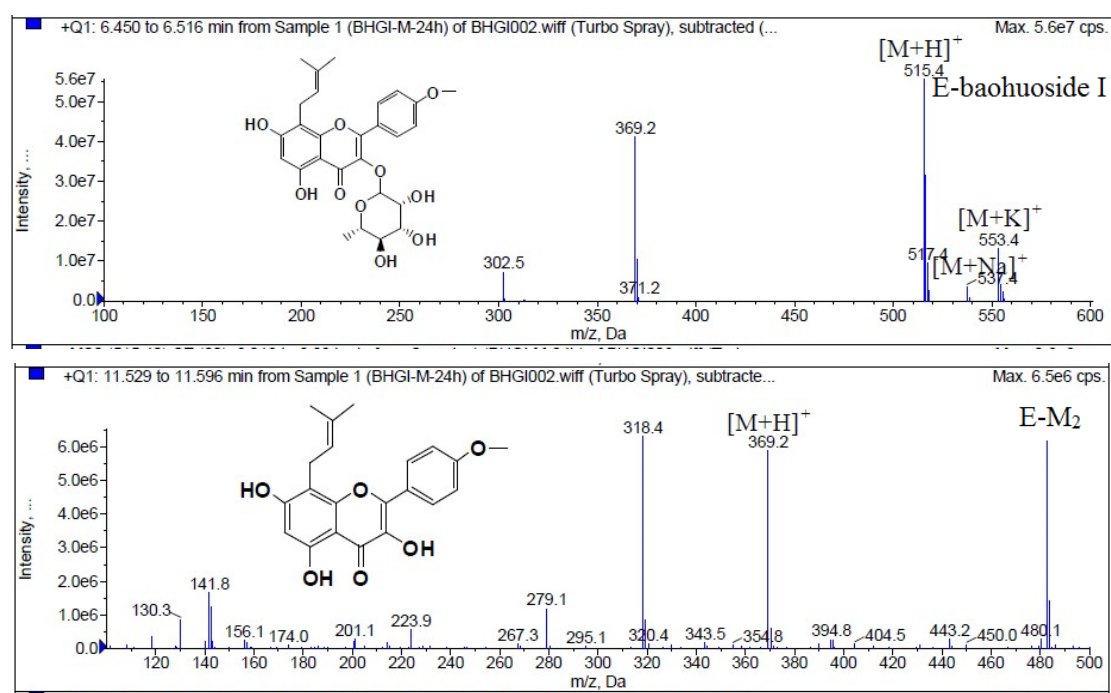
Figure 10. Mass spectra of metabolite of baohuoside I. E for metabolites in intestinal enzyme; F for metabolites in intestinal